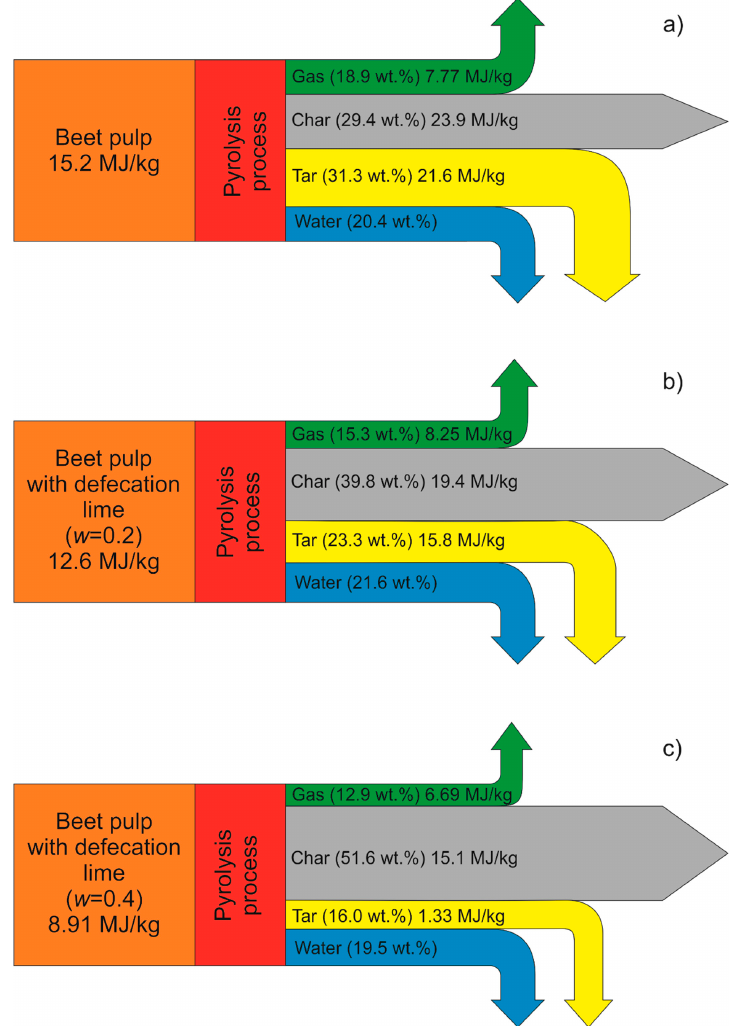
Figure 6. Sankey diagrams for pyrolysis process at temperature 600 °C of samples with mass fraction of defecation lime equal to 0 ( a ), 0.2 ( b ) and 0.4 ( c ).